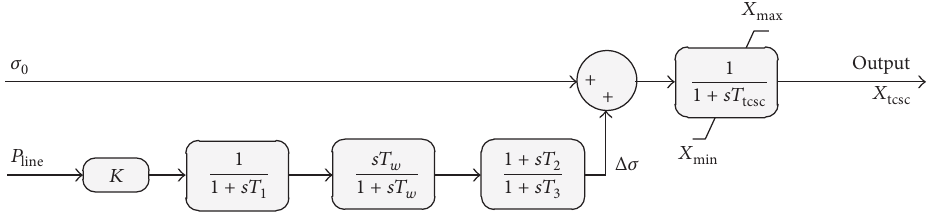
Figure 4: The transfer function mode of TCSC